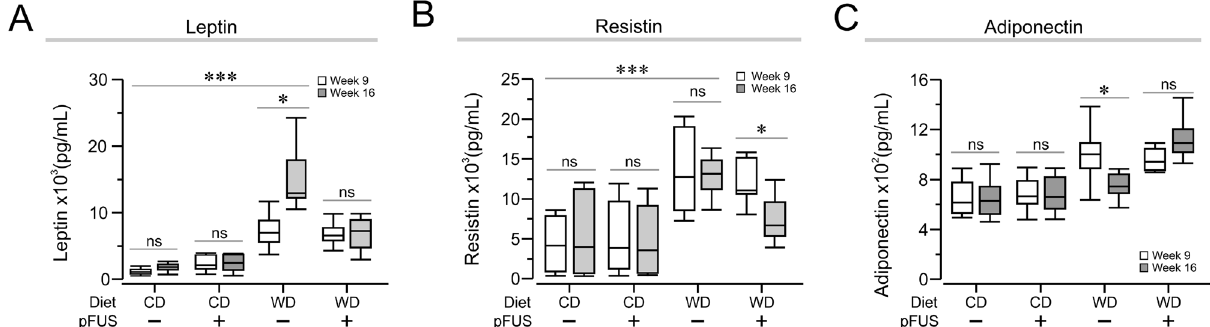
Figure 3. Hepatic pFUS attenuates dysregulation of adipokines in Western diet-fed mice. ( A ) Western diet- sham mice have increased leptin compared to control diet-sham mice (*** P < 0.001, two-way ANOVA). pFUS attenuates leptin increase seen in Western diet–sham mice (WD–sham, week 9 vs week 16, ** P < 0.01, two- way ANOVA). ( B ) Western diet-sham mice have increased resistin compared to control diet-sham mice (*** P < 0.001, two-way ANOVA). pFUS reduces resistin levels in Western diet–pFUS group (* P < 0.05, two-way ANOVA). ( C ) pFUS attenuates the reduction in adiponectin levels seen in Western diet–sham mice (WD–sham, week 9 vs week 16, * P < 0.05, two-way